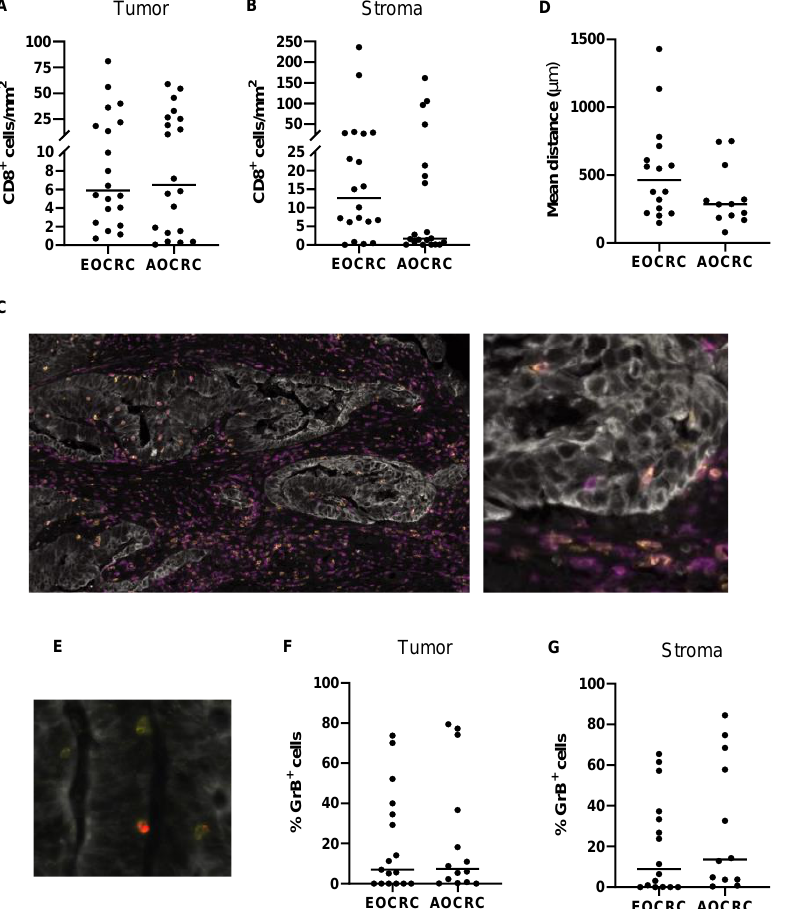
Figure 2. CD8 + T cells in the tumor microenvironment. The density of CD8 + T cells in tumors from early-onset (EOCRC) and average-onset colorectal cancer (AOCRC) patients was determined by im- munofluorescence in tumor tissue ( A ) and tumor stroma ( B ). ( C ) Representative immunofluorescence image from an EOCRC patient with tumor cells (panCK, grey), CD3 + T cells (magenta), and CD8 + T cells (yellow). Magnification 100 × (left) and 300 × (right). ( D ) Mean distance of stromal CD8 + cells to the nearest tumor cell. ( E ) Representative immunofluorescence image with tumor cells (panCK, grey), CD8 + T cells (yellow), and GrB + cells (red). Magnification 500 × . Percentage of CD8 + cells that express Granzyme B (GrB) located in tumor tissue ( F ) and tumor stroma ( G ). Symbols show individual values, and lines indicate the